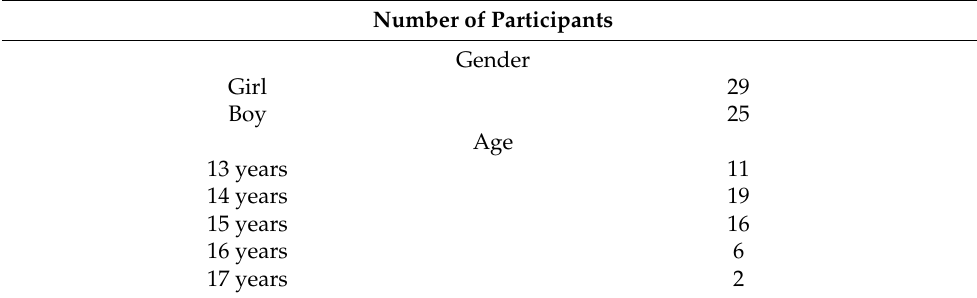
Table 3. Participant